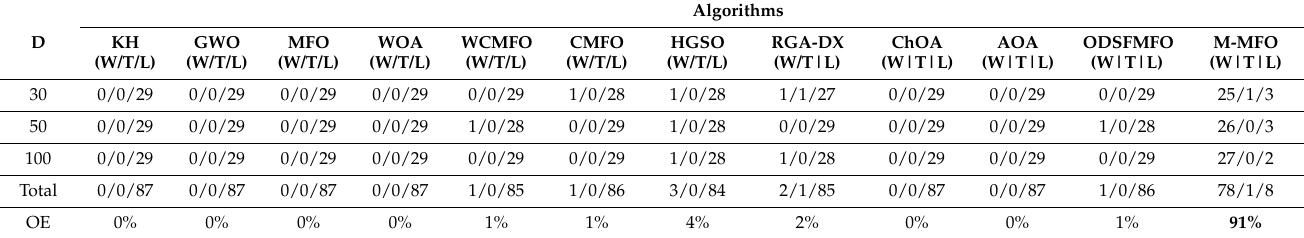
Table 6. The overall effectiveness of the M-MFO and contender